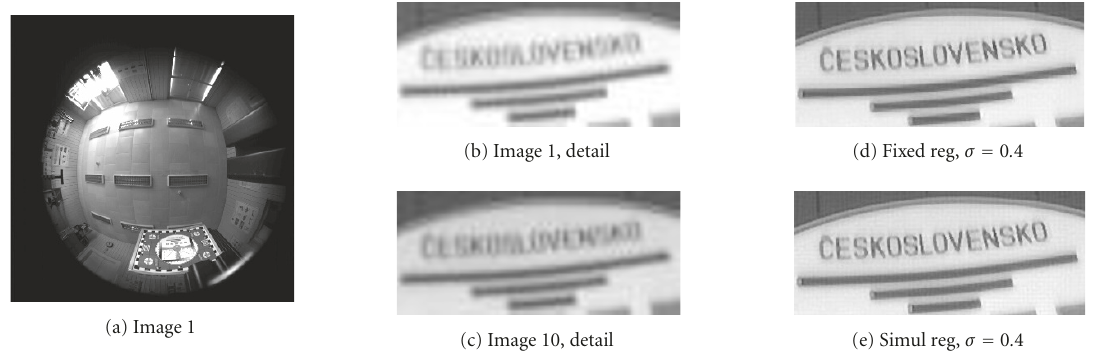
Figure 6: “ ˇCeskoslovensko” sequence. (a) The first image in the sequence. (b), (c) details of the region of interest in the first and last low- resolution images. (d) Super-resolution found using fixed registrations. (e) Super-resolution images using simultaneous MAP